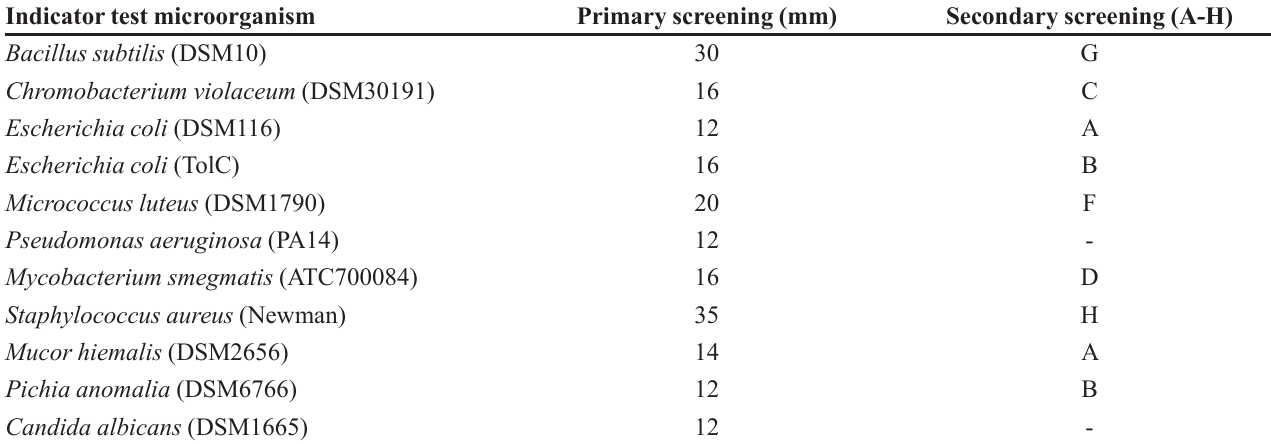
TABLE III – Antimicrobial activity of isolate KRG-1 in primary and secondary screening Indicator test